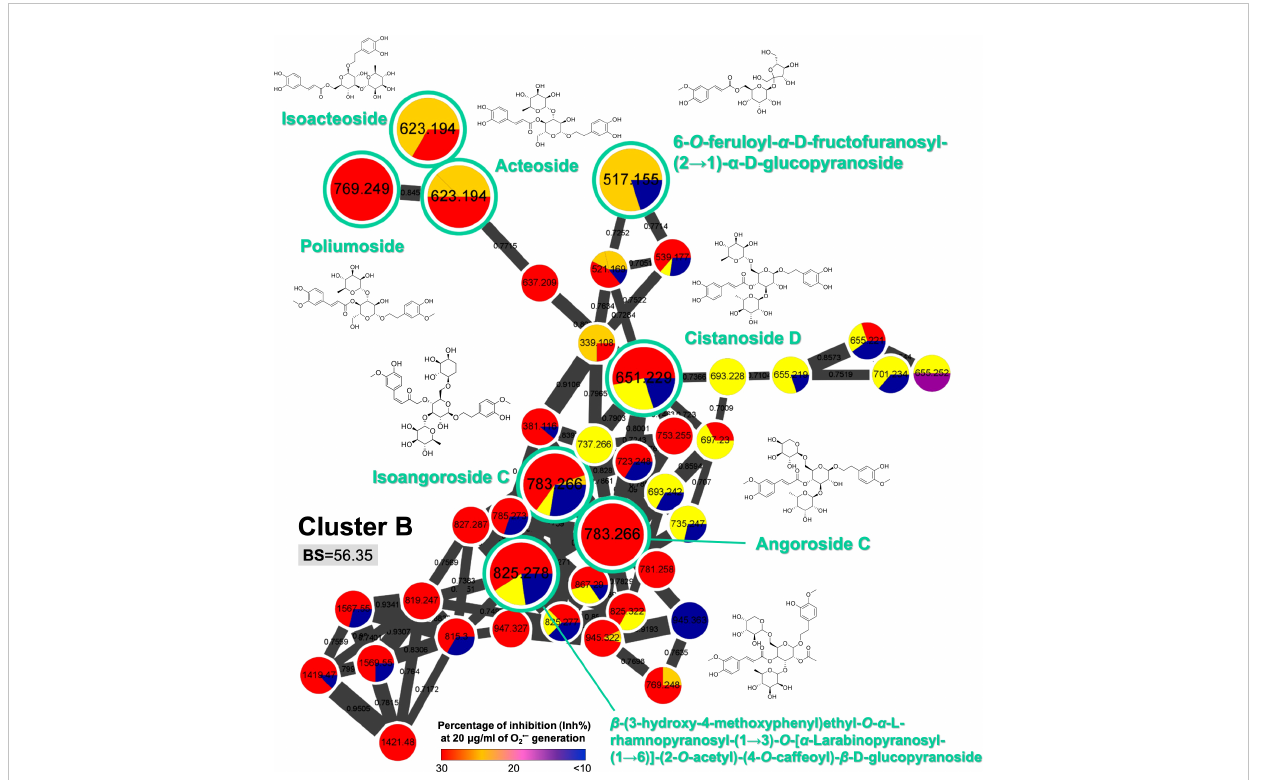
FIGURE 3 The selected MIMN cluster with a high bioactive score (BS ≥ 50) is a potential anti-in fl ammatory chemical group. The putative annotations were conducted based on the MS 2 matching from GNPS and Reaxys databases.